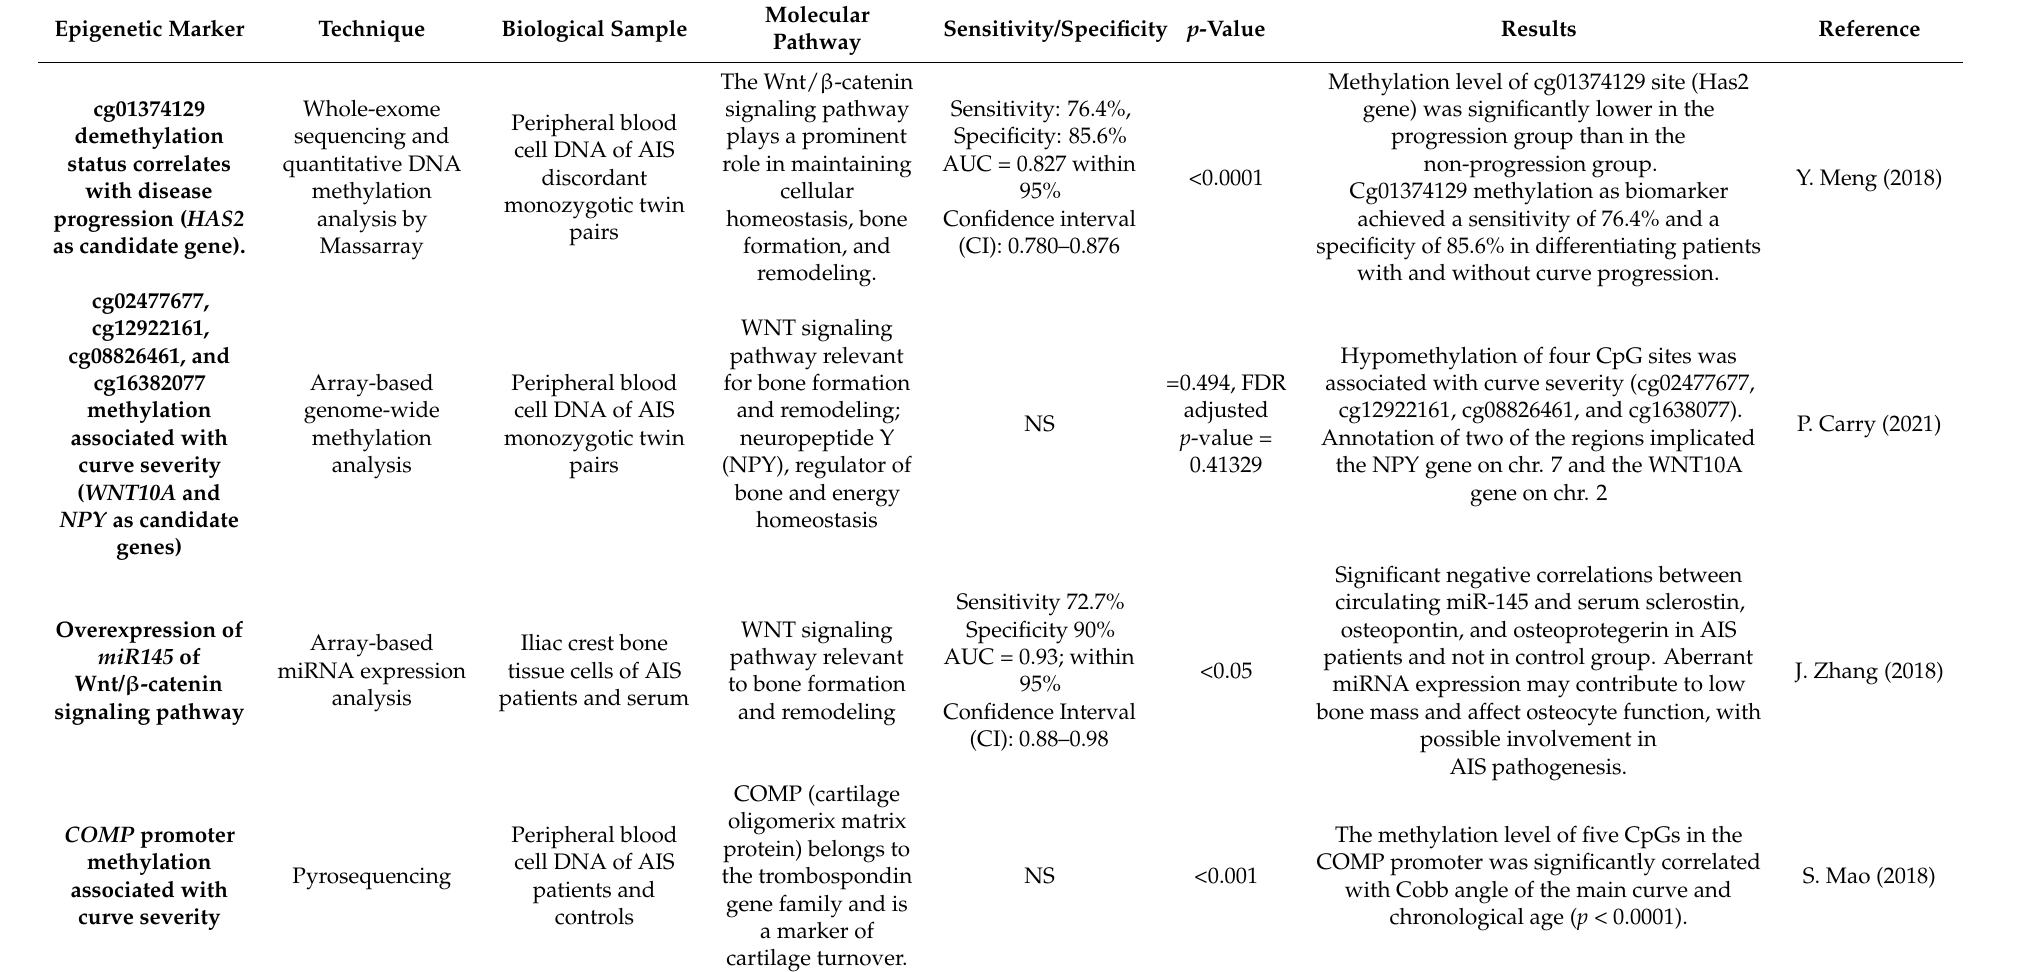
Table 3. Epigenetic factors associated with AIS progression (NS = non-specified, OR = odds ratio, AUC = area under the